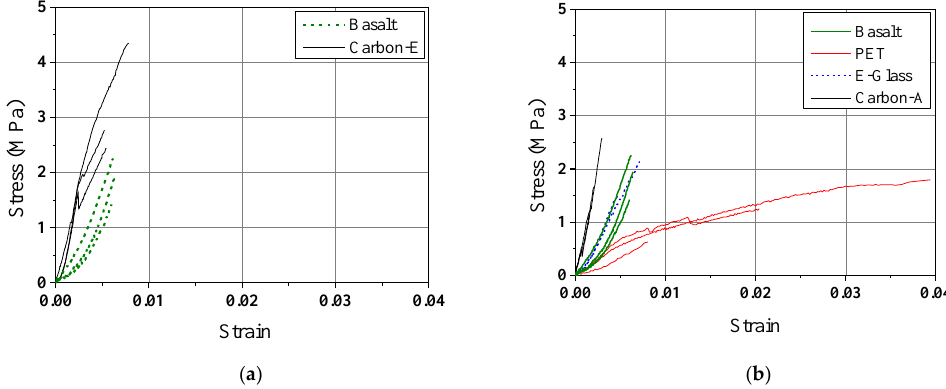
Figure 6. Stress – strain relationships of specimens: ( a ) type of textile; ( b ) type of weaving. Figure 6. Stress–strain relationships of specimens: ( a ) type of textile; ( b ) type of